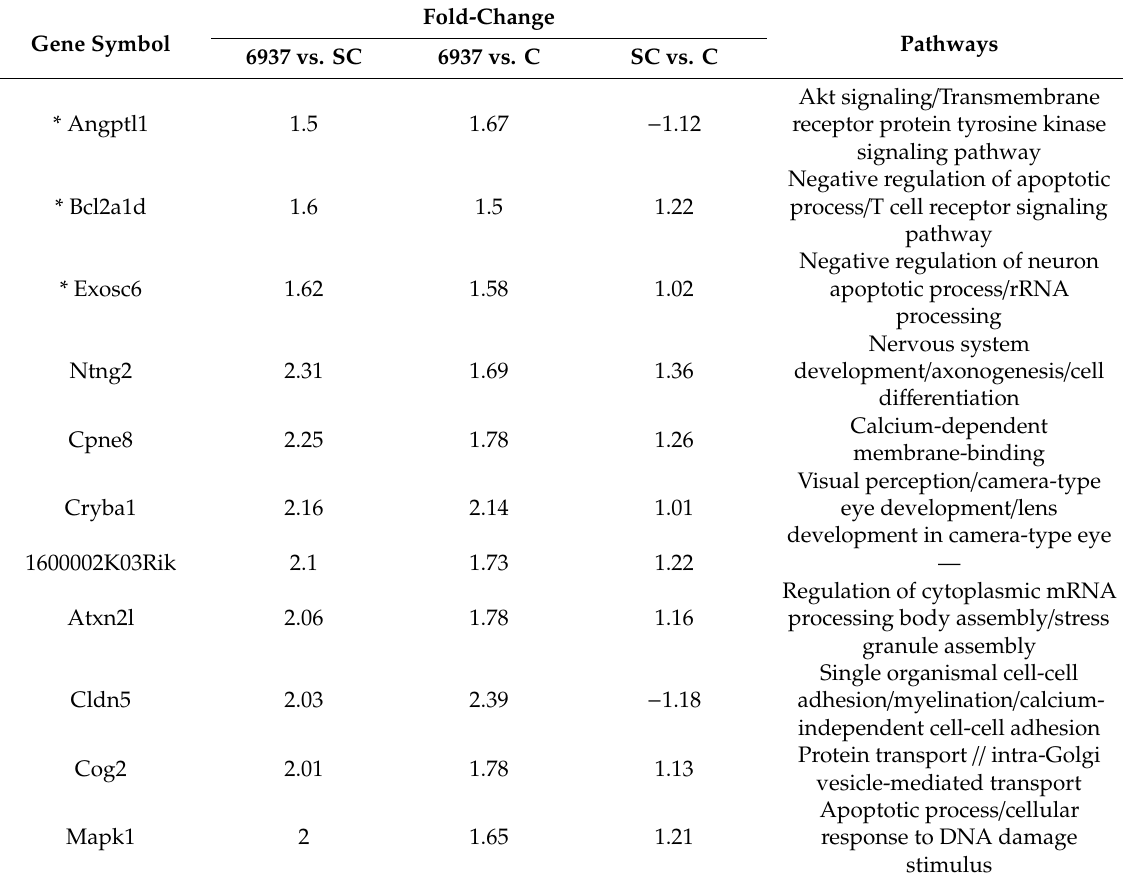
Table 2. Expression levels of those di ff erentially expressed mRNAs after in vivo miR-6937-5p modulation and their associated biological pathways. A sample of 10 di ff erentially expressed mRNAs is shown. For a complete list of 101 mRNAs, see Table S2. Abbreviations: SC: scramble miR; C: control (sham injection). (*) indicates predicted target mRNAs for